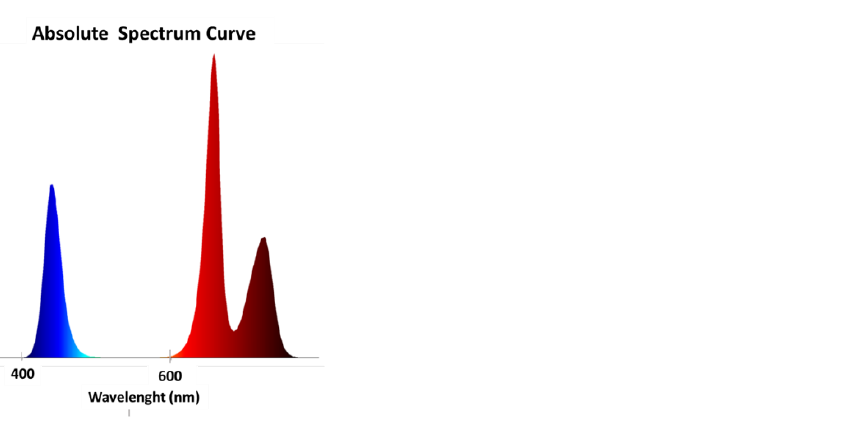
Figure 2. Light spectra utilized for each indoor growing cycle. The specific light spectra was measured by using a portable spectroradiometer (Everfine, PLA 20).